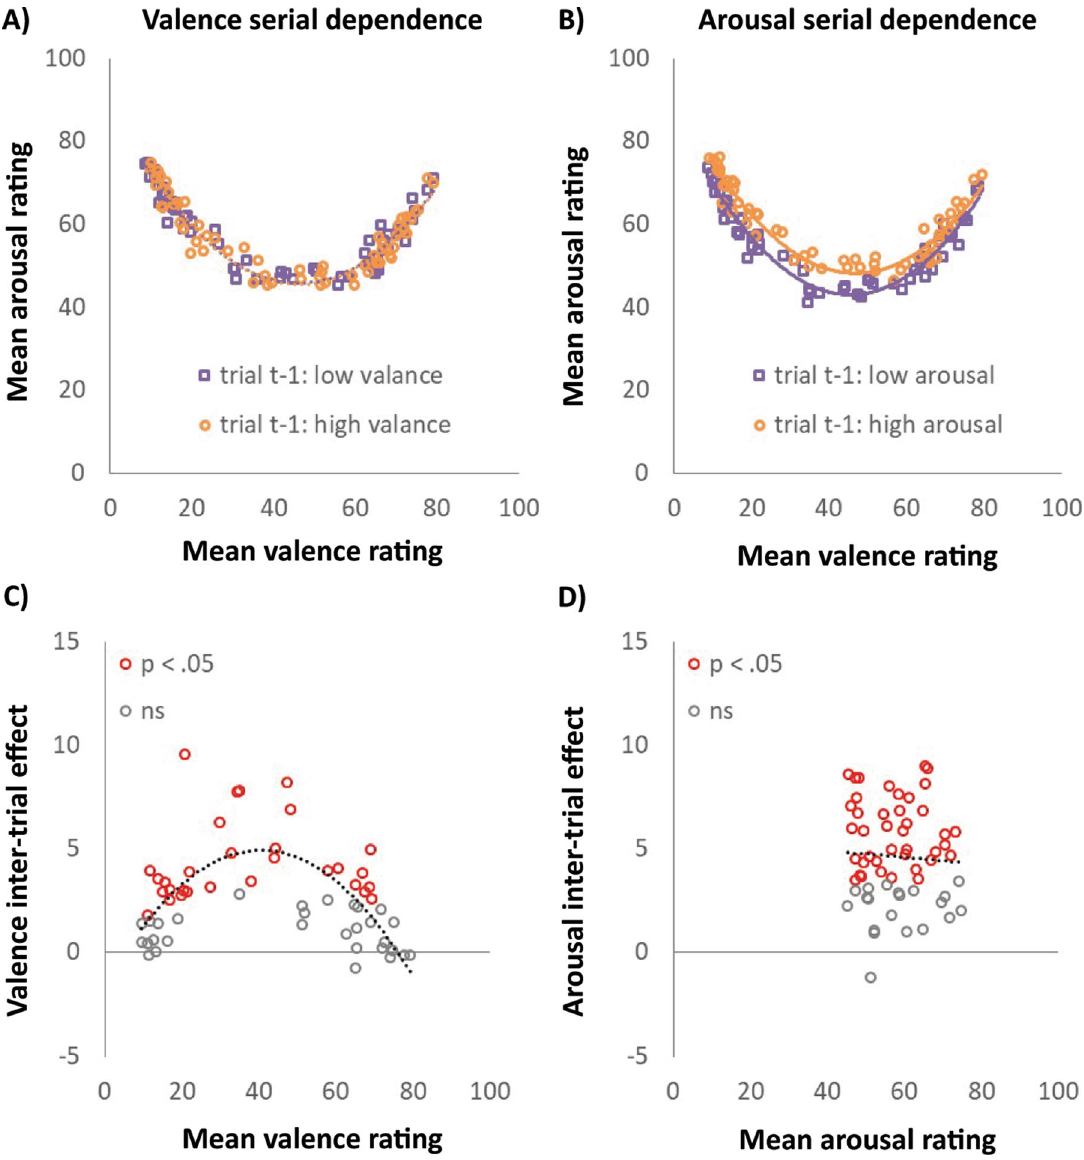
mean valence rating for each of the 60 food images. In panel A , the orange circles signify those trials whereby the image was preceded by an image with a high valence rating, whereas the purple squares signify the opposite. In panel B , the orange circles signify those trials in which the image was preceded by an image with a high arousal rating, whereas the purple squares signify the opposite. C Valence inter-trial effect as a function of the mean valence rating for each food image. Red circles indicate a signi fi cant difference ( p < 0.05; two-tailed independent t -test), whereas grey circles signify non-signi fi cant differences. D Arousal inter-trial effect as a function of the mean arousal rating for each food image. Note that the continuous lines in all panels represent quadratic fi ts to the data points (see also Kaneko et al.,